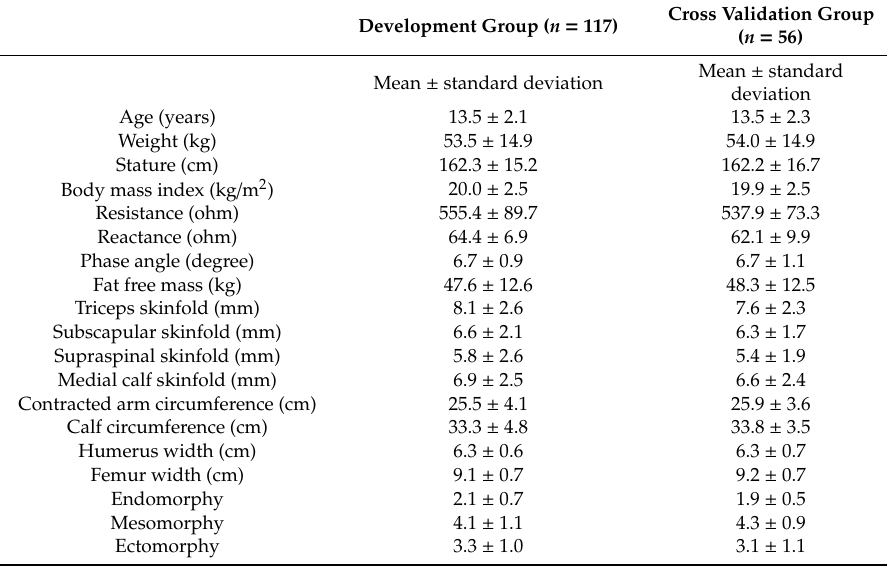
Table 1. Descriptive Characteristics of the Development and Cross validation Groups.